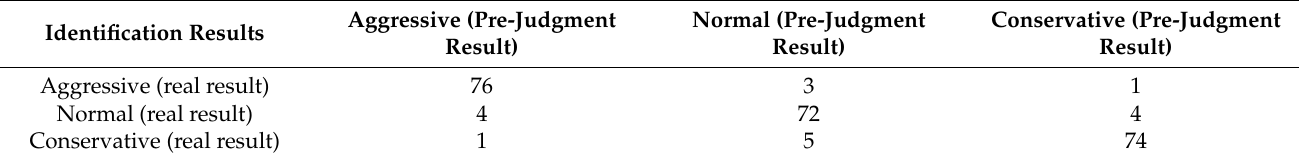
Table 14. FOA-GRNN driving propensity identification results.